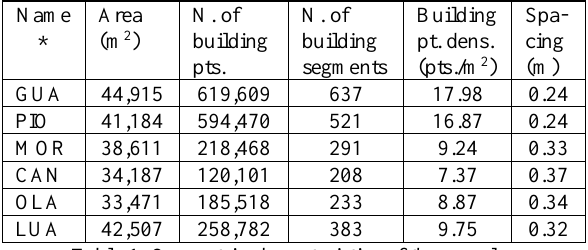
Table 1. Geometric characteristics of the